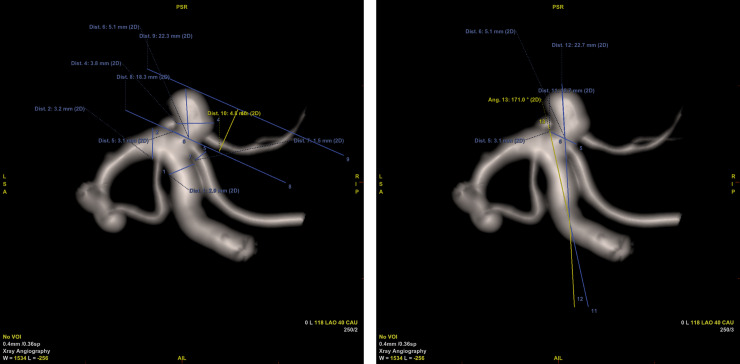
Schematic morphological measurements on 3D angiography.Please refer to caption for Table 2. Dist. 1 –diameter of afferent parent artery; Dist. 2 –diameter of efferent parent artery; Dist. 4 –width of the sac; Dist. 6 –length of the sac (Dmax); Dist. 10 –height of the sac; Ang. 13 –delta angle.